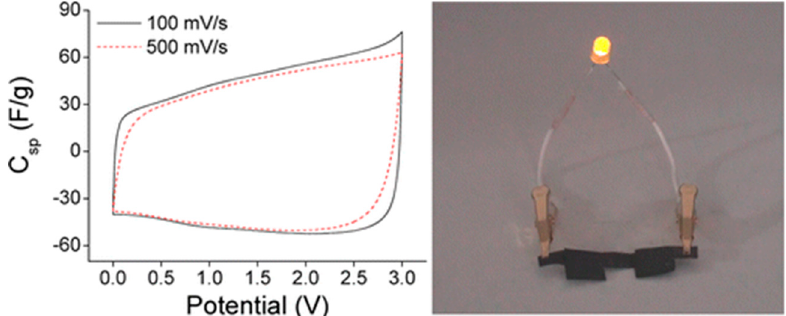
Figure 7. Characteristics of CNT/BNC/ion gel-based all-state flexible supercapacitors. The left figure shows cyclic voltammetry (CV) curves measured at scan rates of 100 and 500 mV/s. The right figure shows a photograph of a light-emitting diode (LED) turned on by the flexible supercapacitors. Reproduced with permission from [120]. Copyright American Chemical Society, 2013.